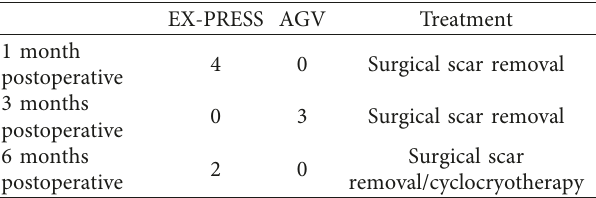
Figure 3: (a) The Kaplan–Meier survival curve for all of the eyes (all data referred to total success rate). (b) The Kaplan–Meier survival curve based on surgical procedures (Ahmed glaucoma valves or EX-PRESS) (all data referred to total success rate). Table 3: Distribution of surgical failures in this